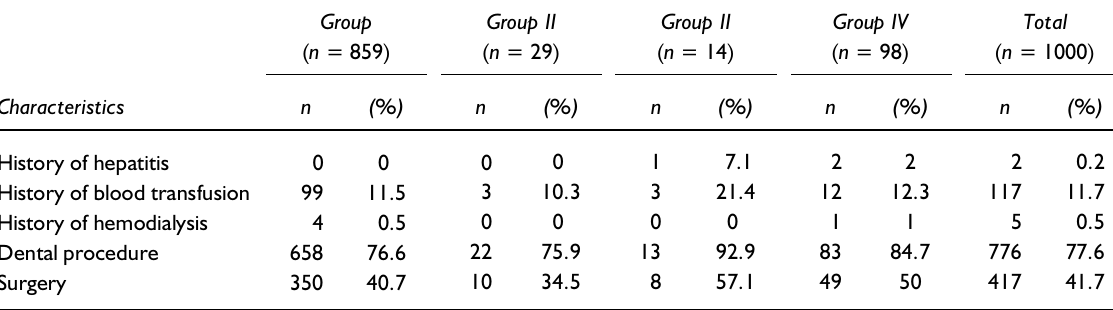
Table 4 Prevalence of HBV infection in pregnant Jordanian women in relation to risk